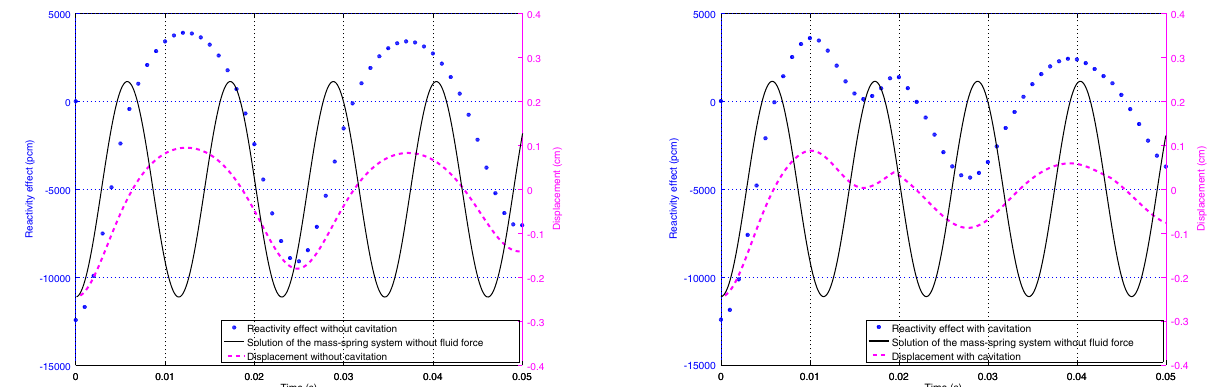
Figure 4: Assembly displacement and reactivity effect with (left) or without (right)